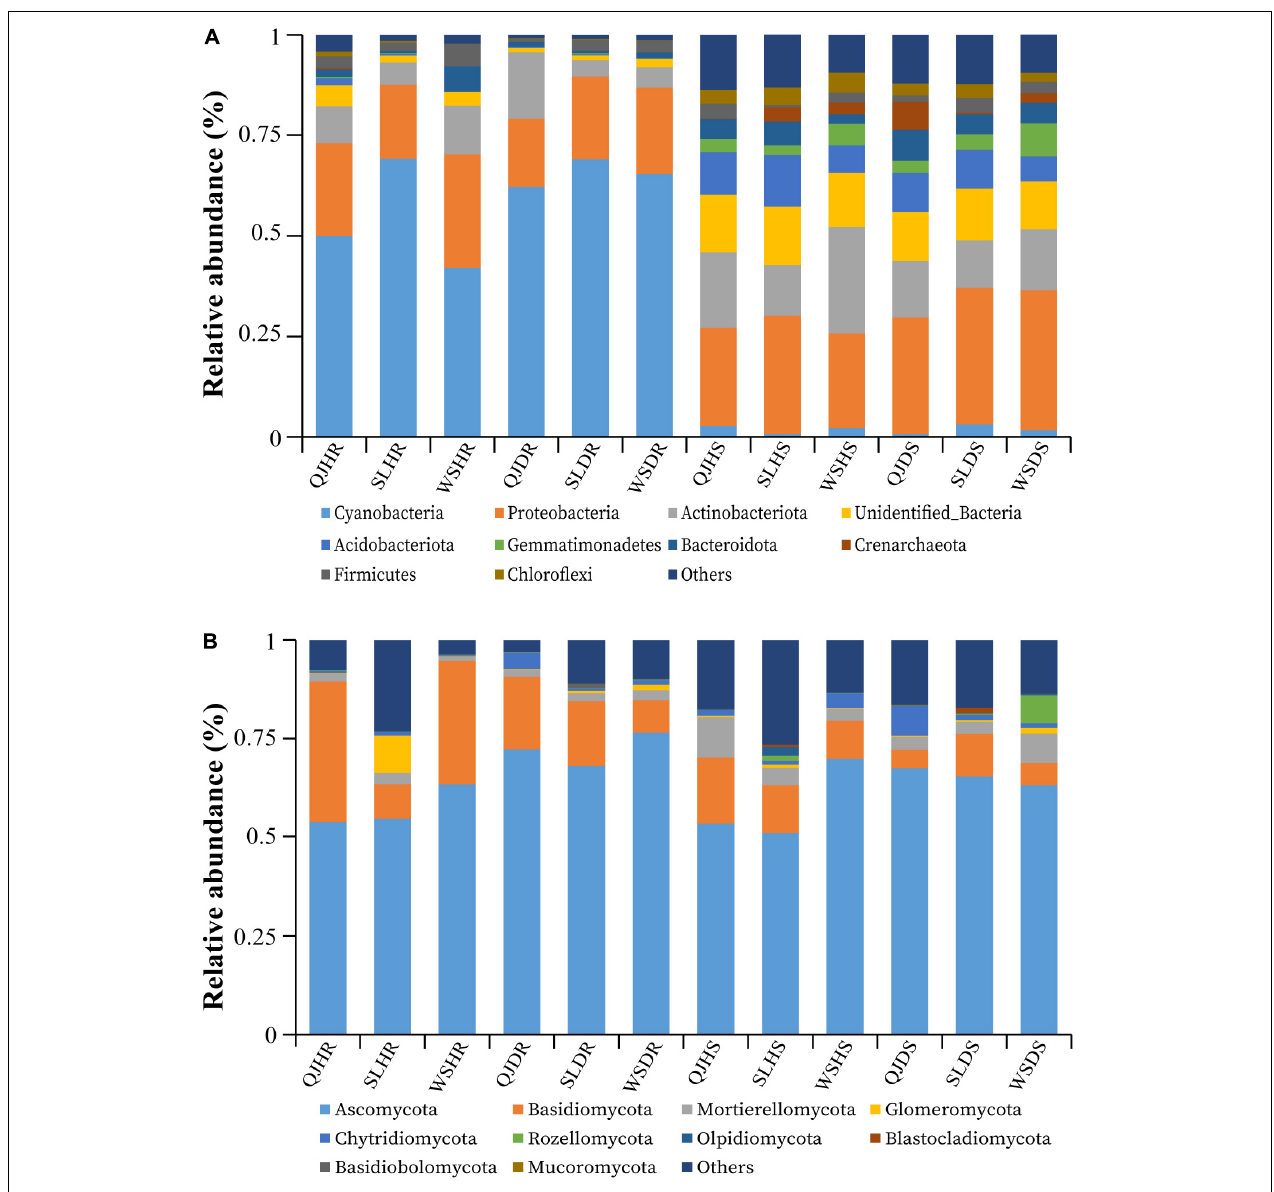
FIGURE 5 | Relative abundance bar plots at phylum level based on the species annotation results in 12 composite samples (average of three replicates per sample) of flue-cured tobacco plants under three variables. (A) Relative abundance at the phylum level in bacterial communities and (B) relative abundance at the phylum level in fungal communities. QJ, Qujing; SL, Shilin; WS, Wenshan; HS, healthy rhizosphere soil; DS, diseased rhizosphere soil; HR, healthy roots; DR, diseased